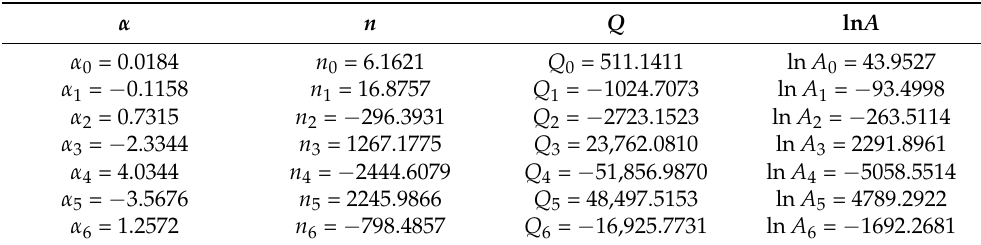
Table 2. The coefficients of the Arrhenius model for the 25CrMo4